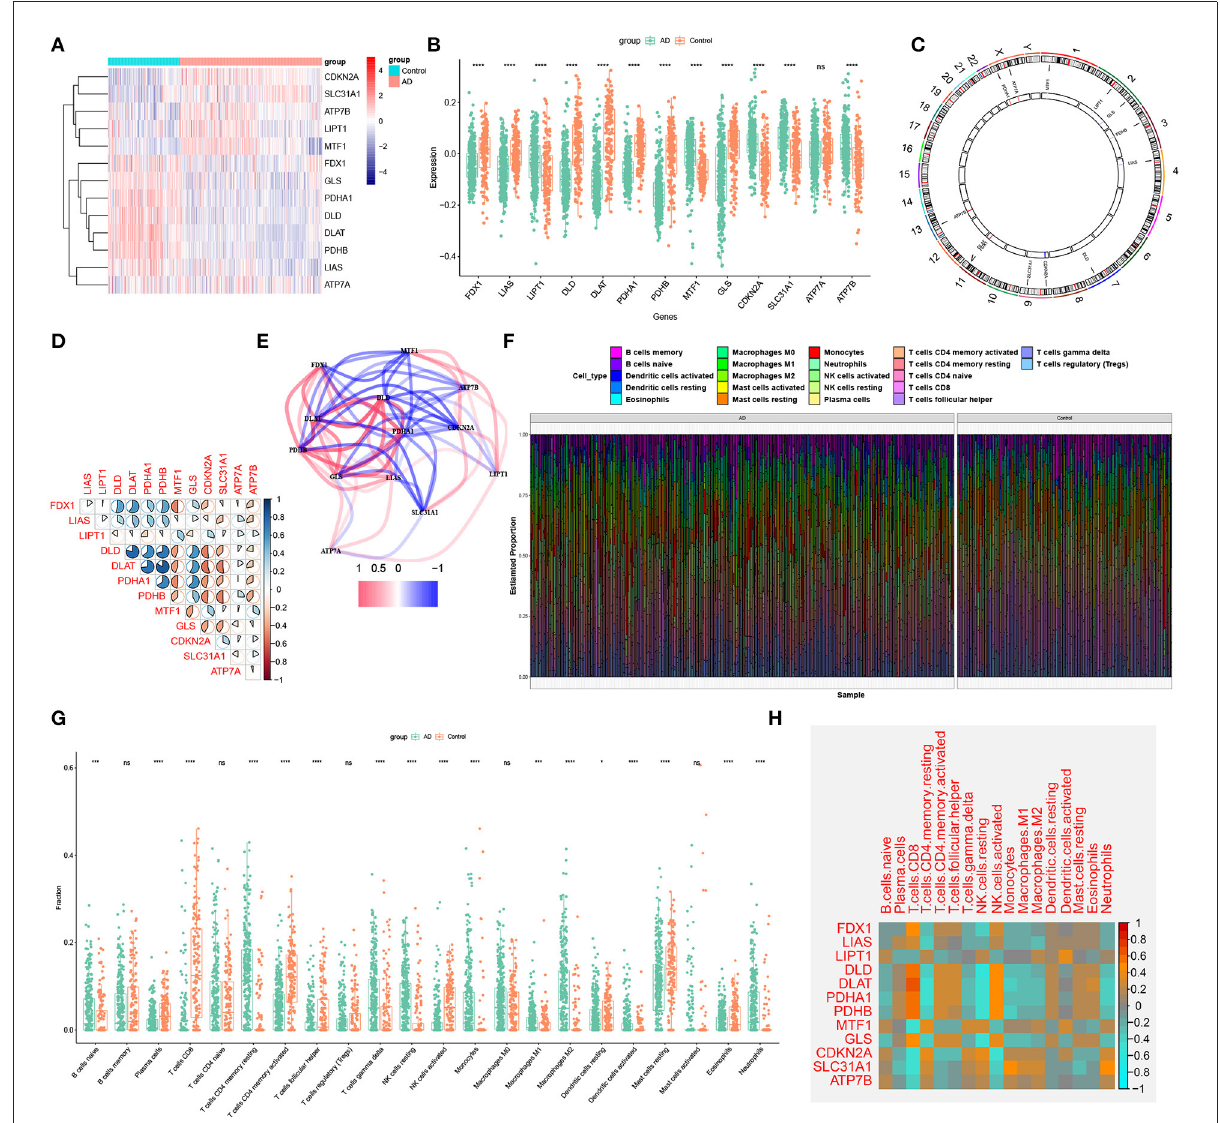
FIGURE2 Identification of dysregulated CRGs in AD. (A) The expression patterns of 13 CRGs were presented in the heatmap. (B) Boxplots showed the expression of 13 CRGs between AD and non-AD controls. **** p < 0.0001, ns, no significance. (C) The location of 13 CRGs on chromosomes. (D) Correlation analysis of 12 differentially expressed CRGs. Blue and Red colors represent positive and negative correlations, respectively. The correlation coefficients were marked with the area of the pie chart. (E) Gene relationship network diagram of 12 differentially expressed CRGs. (F) The relative abundances of 22 infiltrated immune cells between AD and non-AD controls. (G) Boxplots showed the differences in immune infiltrating between AD and non-AD controls. * p < 0.05, *** p < 0.001, **** p < 0.0001, ns, no significance. (H) correlation analysis between 12 differentially expressed CRGs and infiltrated immune cells.